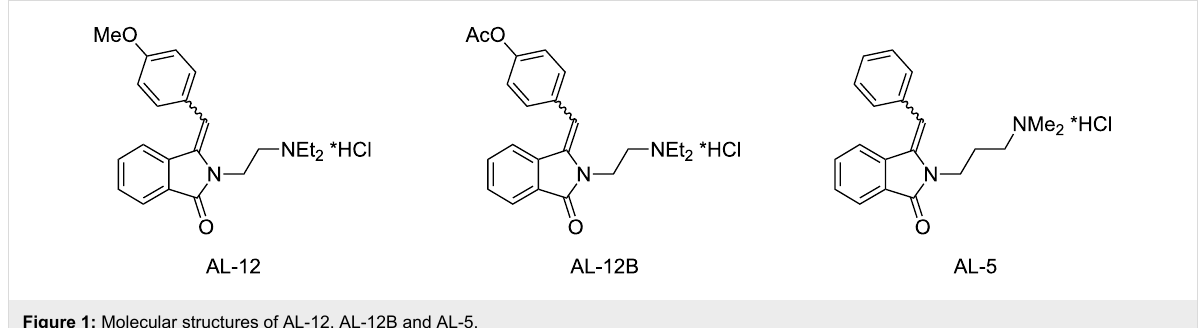
Figure 1: Molecular structures of AL-12, AL-12B and AL-5.